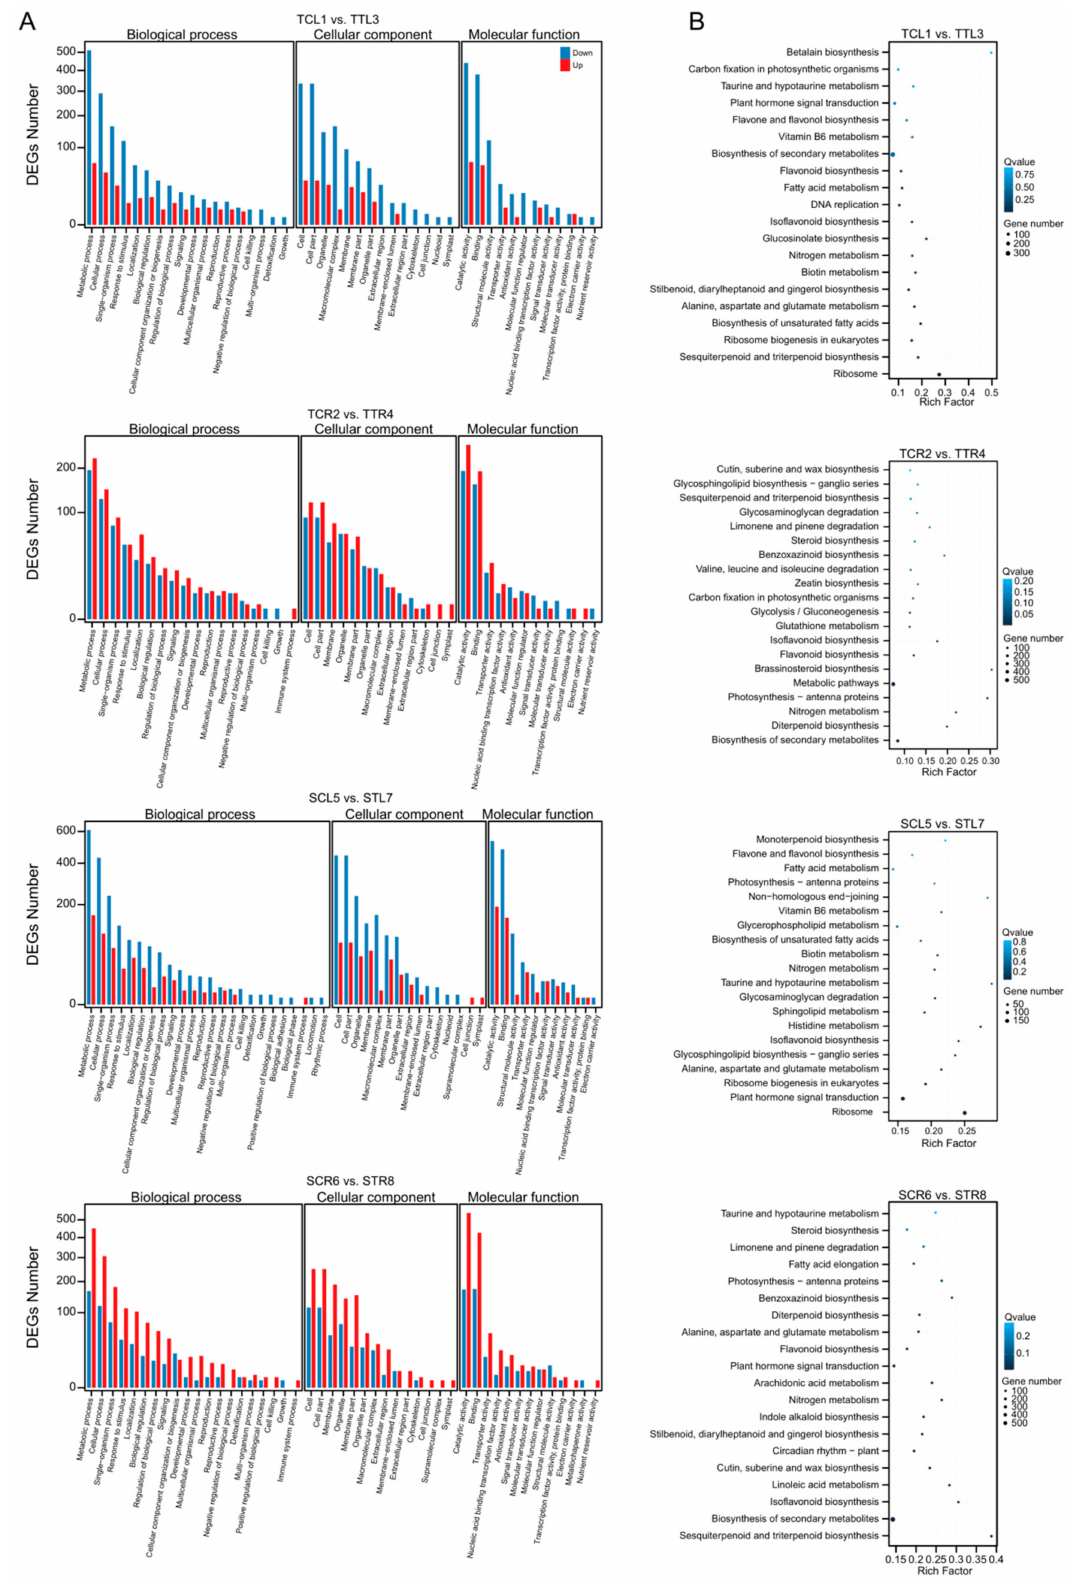
Figure 4. Function classifications of DEGs. ( A ): GO functional enrichment analysis of DEGs. The X-axis represents GO functional classification, and the Y-axis represents the number of up-regulated and down-regulated genes in each corresponding GO term. ( B ): Pathway enrichment analysis of DEGs. The X-axis represents enrichment factor values, and Y-axis represents pathway